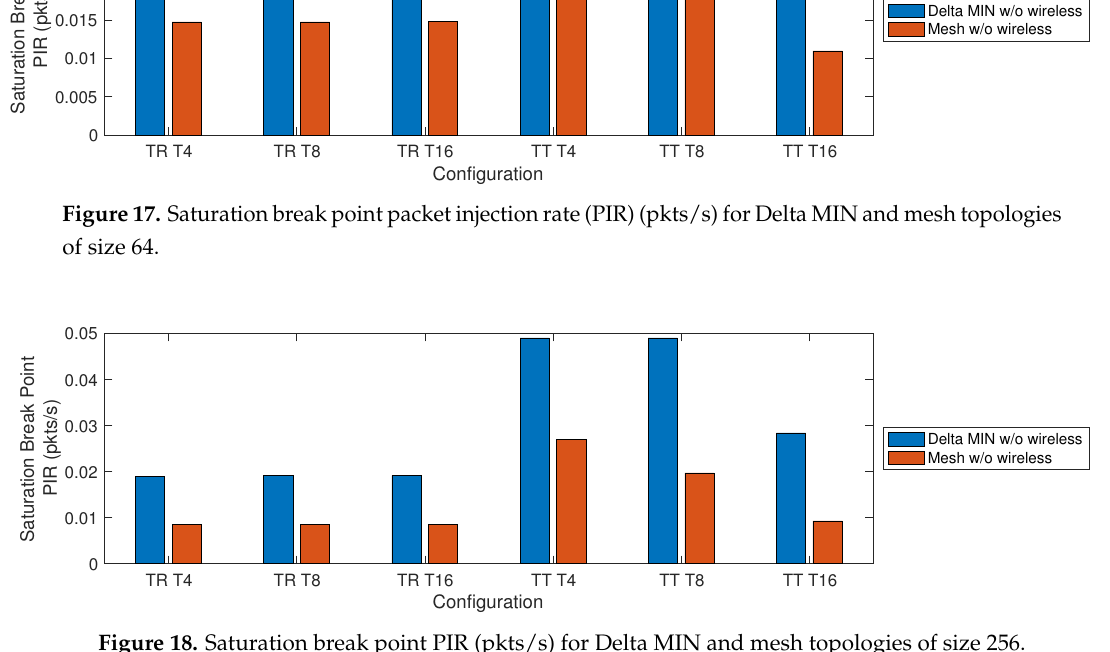
Figure 18. Saturation break point PIR (pkts/s) for Delta MIN and mesh topologies of size 256.